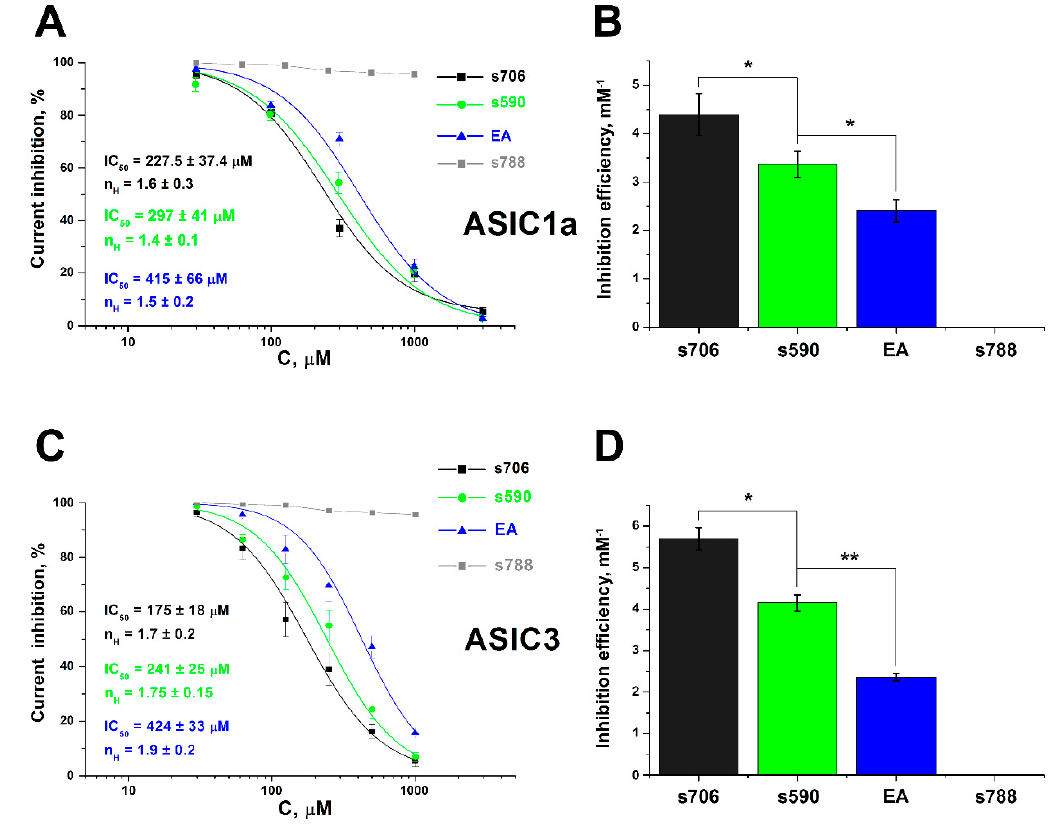
Figure 2. The inhibitory activity of sevanol ( s706 ) and its analogues. Currents were elicited by a drop from pH 7.4 to 5.5; the holding potential was − 50 mV; ( A , C ) are dose–response curves for s706 , s590 and EA inhibitory effects on ASIC1a and ASIC3 channels, respectively; ( B , D ) are reciprocal IC 50 values for s706 , s590 and EA inhibitory effects on ASIC1a and ASIC3 channels, respectively. The data were fitted by the logistic equation. Each point is the mean ± SEM of 5–6 measurements. * p < 0.05, ** p < 0.005.